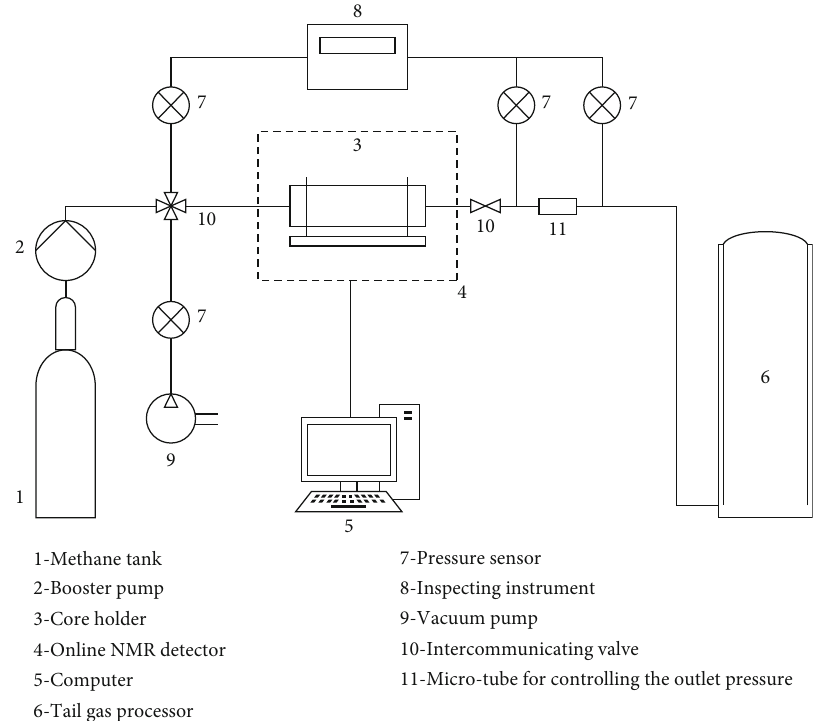
Figure 1: Flow diagram of the NMR experiment for analyzing shale gas depletion